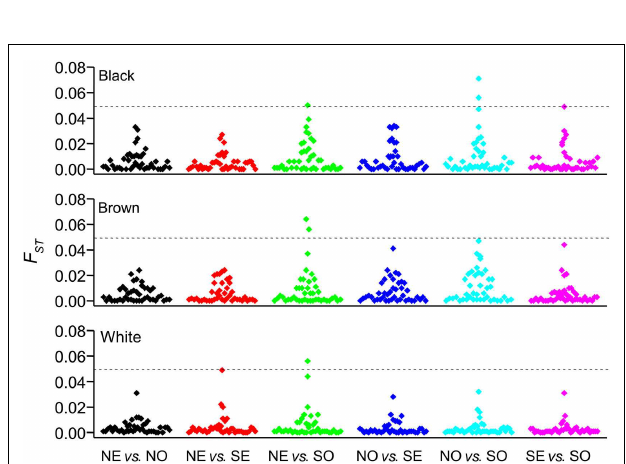
FIGURE 4 |Allele-specific F ST values ( y -axis) for pair-wise comparisons between geographical regions ( x -axis). Data are presented separately for self-identified Black (top panel), Brown (middle panel), andWhite (bottom panel) individuals. Each symbol correspond to one of the 44 polymorphisms listed in Table 1 .The dashed line shows the threshold F ST values (0.05) for moderate genetic divergence. NO, North; NE, Northeast; SE, Southeast; SO,